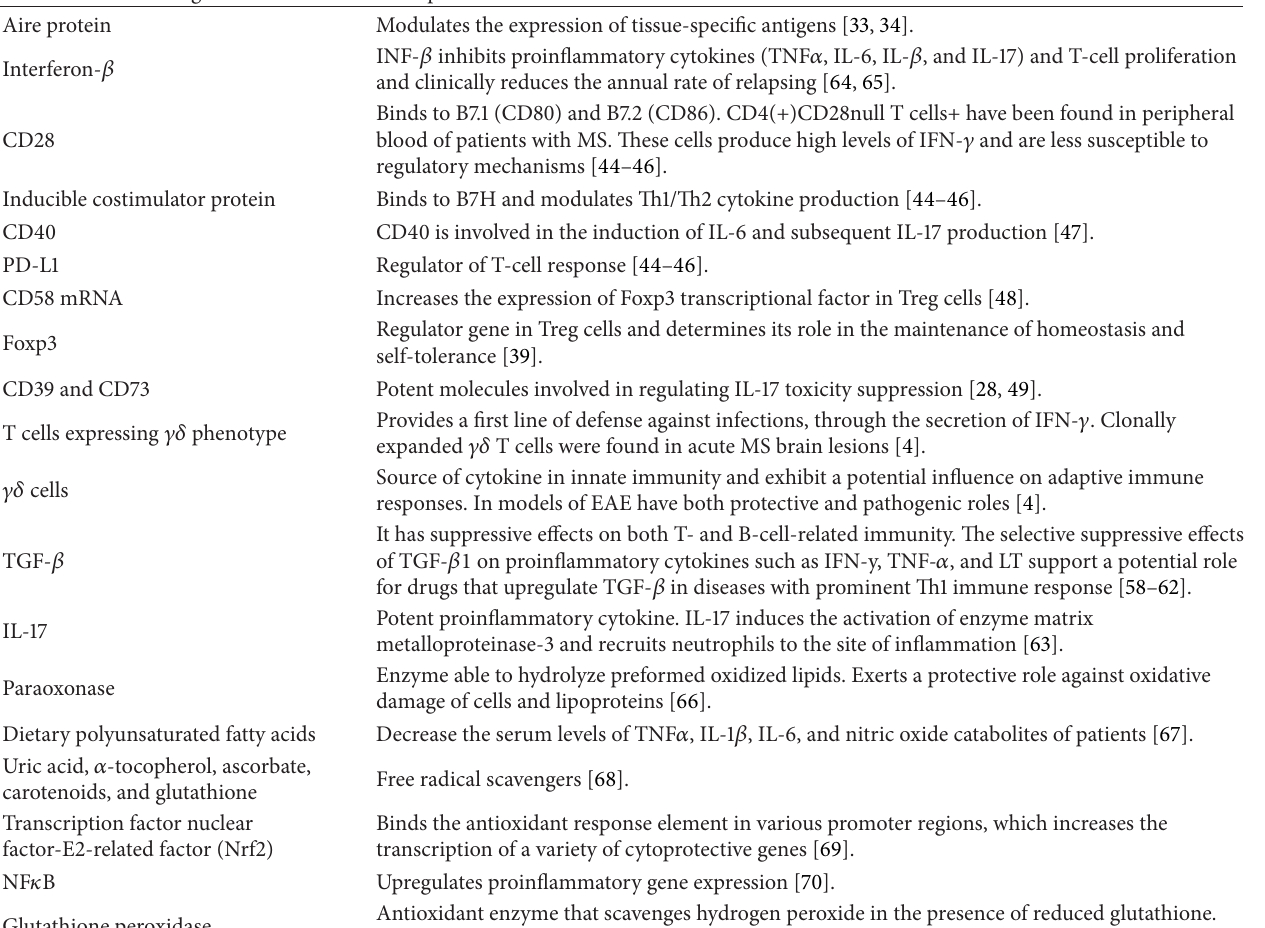
Table 1: Therapeutic strategies for multiple